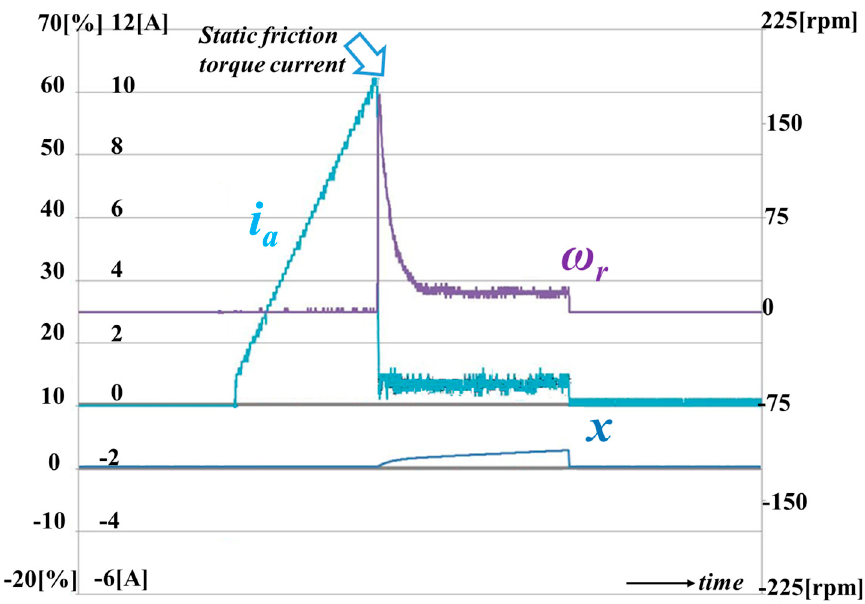
Figure 4. Static friction torque measurement at zero valve position (green: current, purple: speed, blue: position).